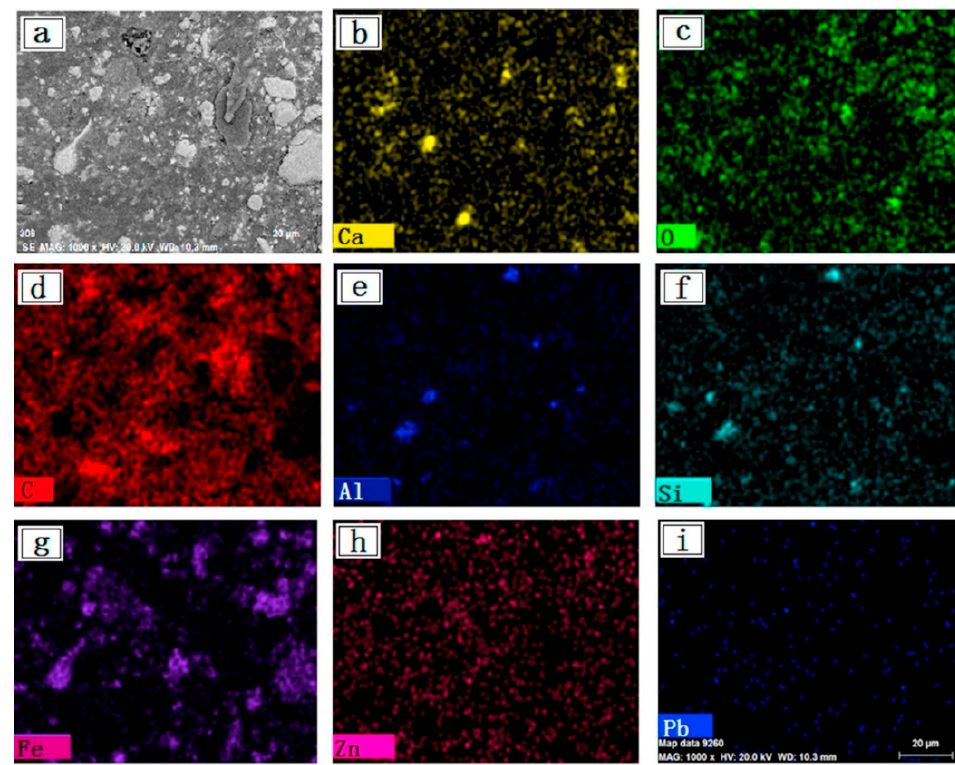
Figure 2. SEM image and element distribution of BF dust, ( a ) SEM; ( b ) Ca; ( c ) O; ( d ) C; ( e ) Al; ( f ) Si; ( g ) Fe; ( h ) Zn; ( i ) Pb [13].